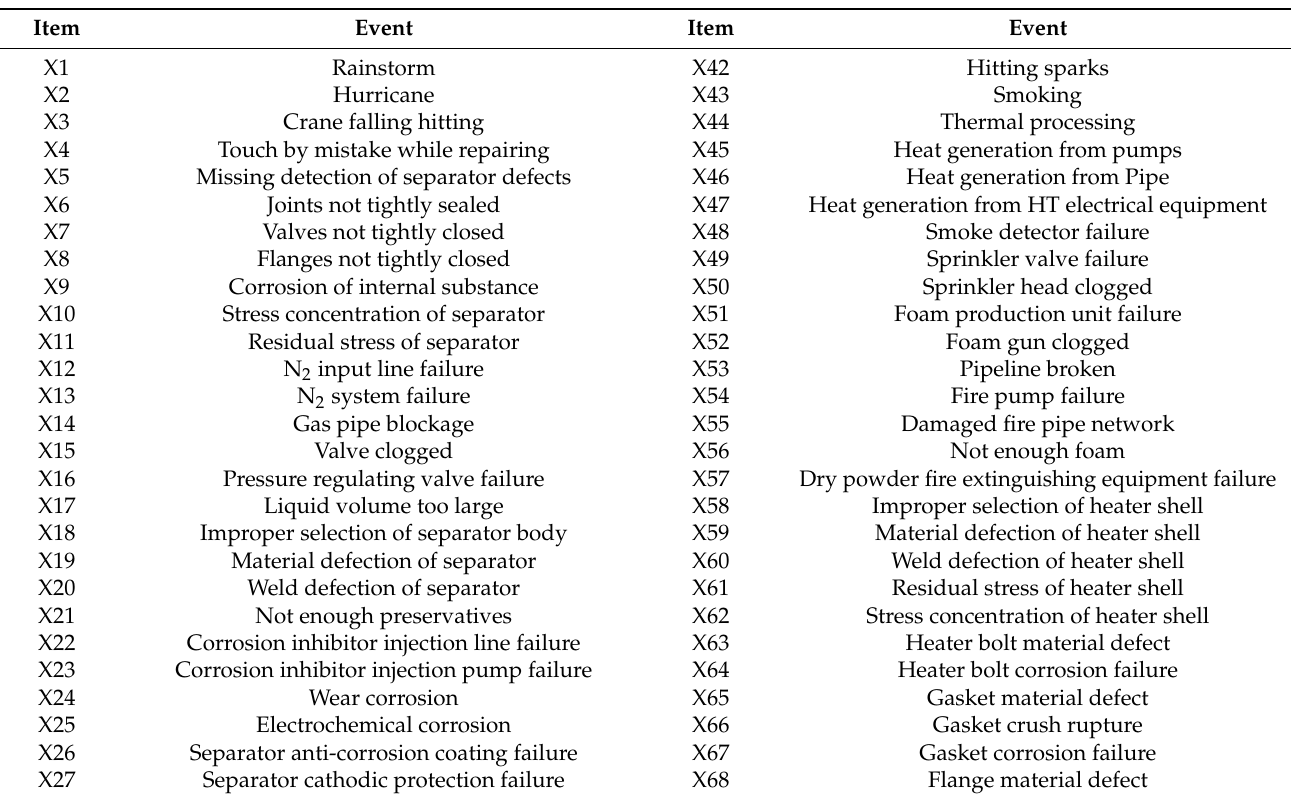
Figure 7. The BT model of oil leakage. “ X ” , “ M ” , and “ T ” constitute the basic events, intermediate events, and top events of FTA, respectively. I1 – I5 represent control and mitigation barriers in ETA, and C1 – C6 represent accident consequences. The basic event symbol description is shown in Table